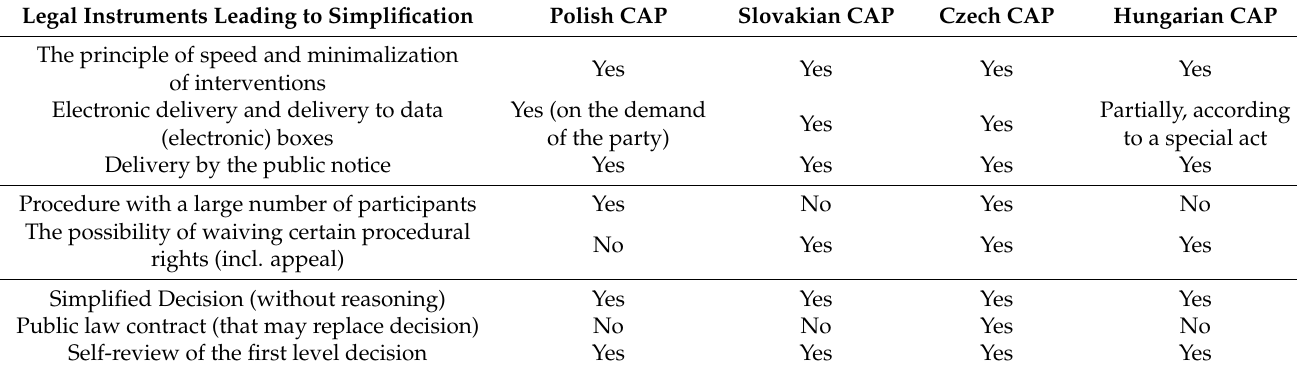
Table 2. Examples of Possible Simplifications in the Code of Administrative Procedure), (CAP) of the V4 Countries. Legal Instruments Leading to